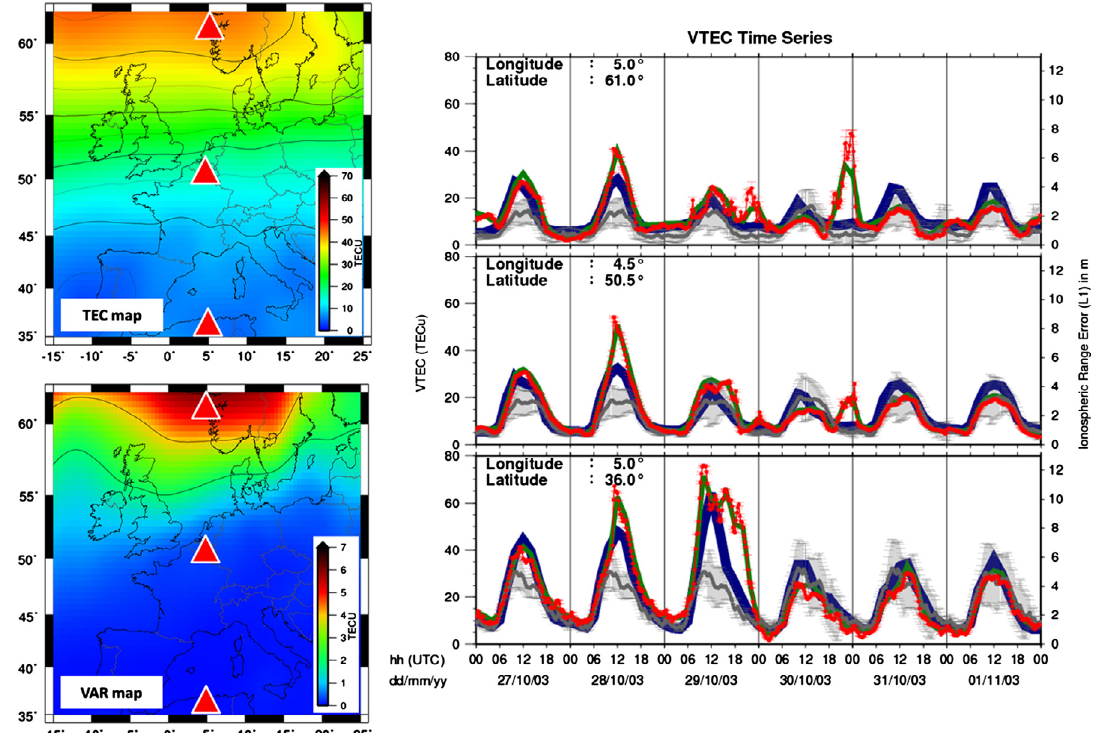
Fig. 4. NRT ROB-TEC maps during the 2003 Halloween storm. Left: ROB-TEC maps estimated between 22:15 and 22:30 UTC for October 30, 2003. Left top: ROB-TEC map estimated in NRT. Left bottom: ROB-TEC variability map during the 15-min time span. Right: 6-day vTEC time series extracted from ROB-TEC maps at three different geographic locations represented by the red triangle on the maps (top: northern part of the maps; middle: above Brussels, bottom: southern part of the maps). The red dots are the vTEC time series estimated in NRT. The grey dots represent the expected ionospheric behaviour based on the median vTEC from the 15 previous days. The green and blue lines are the interpolated values from the IGS and ESA final GIMs respectively.